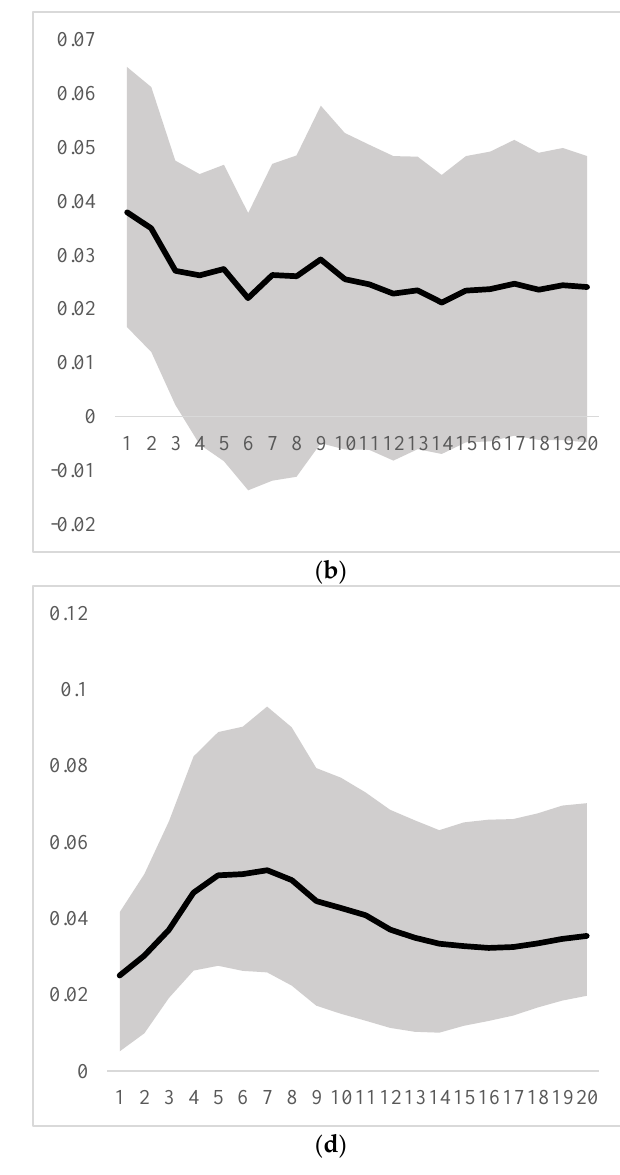
Figure 5. Accumulated quarterly structural impulse response functions. Source: authors’ estimation. Note: The shaded area indicates 95% confidence interval from bootstrap simulation with 500 replications. The shocks are the quarterly positive one standard deviations. Horizontal axis is in quarters. ( a ) Real exchange rate to real shock; ( b ) nominal exchange rate to real shock; ( c ) real exchange rate to nominal shock; ( d ) nominal exchange rate to nominal